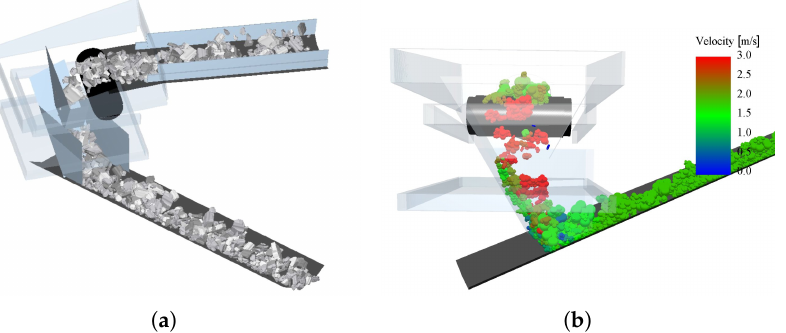
Figure 10. Simulation of material flow through the new transfer station at a capacity of 900 Mg/h: ( a ) visualization and ( b ) velocity of the particles.